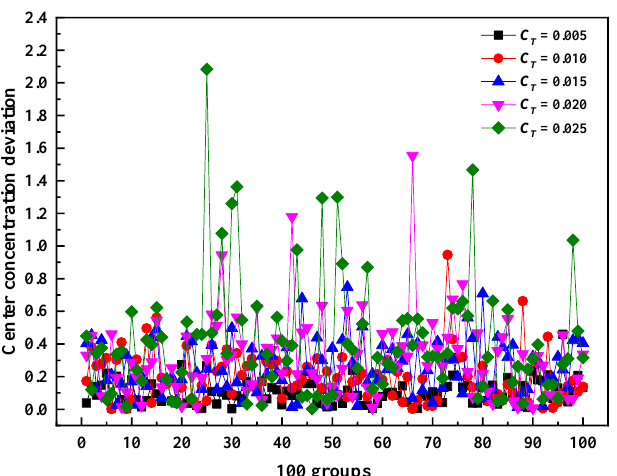
Figure 14. Center concentration deviation under the different relative standard deviations of temperatures at velocity 2.1 m/s.